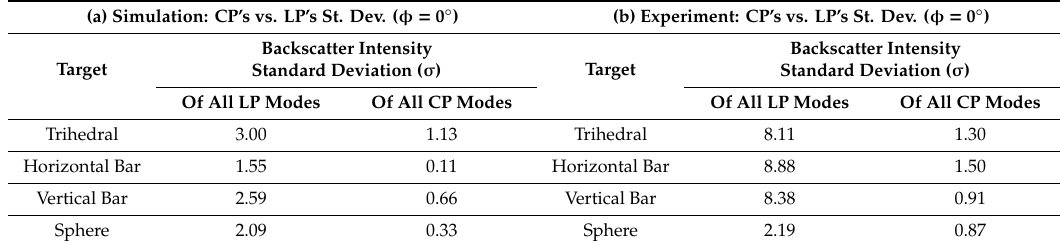
Table 4. Comparison of the standard deviations of CPs and LPs for every target: ( a ) According to the simulation, and ( b ) according to the